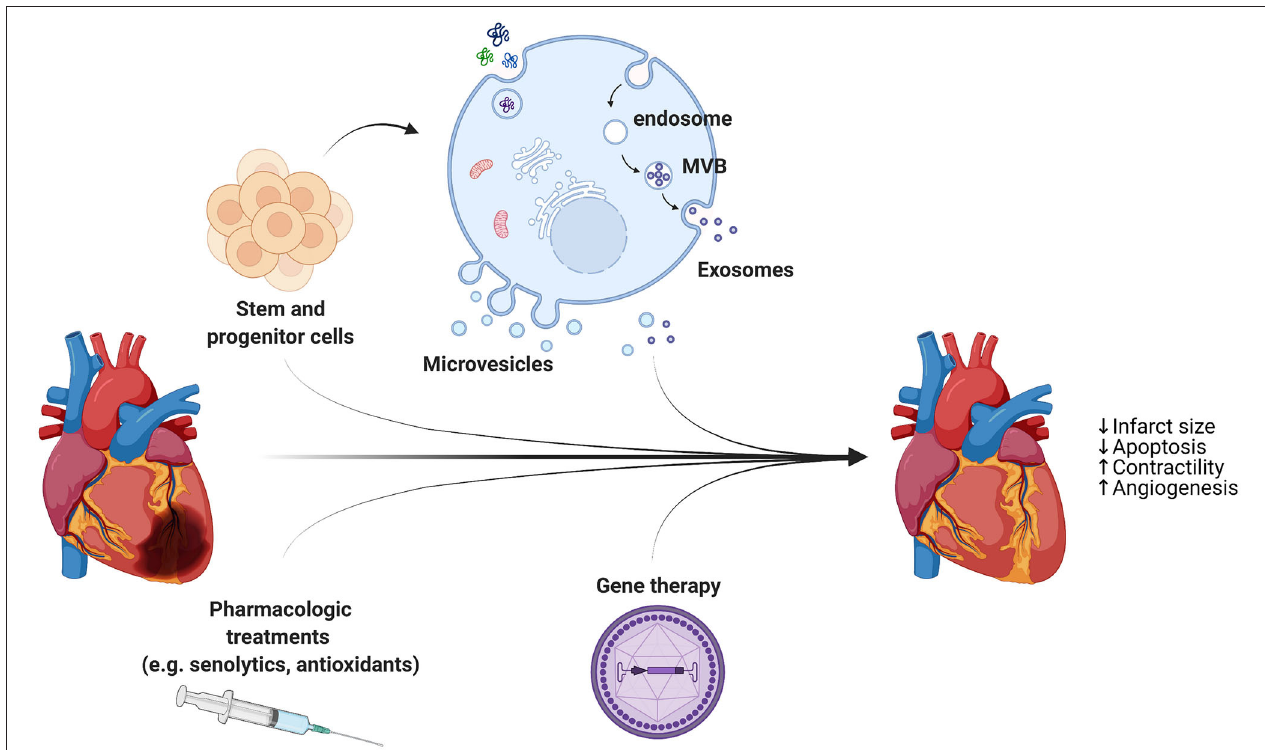
FIGURE 2 | In addition to reperfusion therapy, cardioprotective strategies are necessary to reduce the infarct size and repair the injured myocardium. A combination of different approaches, including stem cell- and progenitor cell-derived extracellular vesicles, pharmacologic treatments, and AAVs for gene therapy, holds great promise for heart regeneration through limiting cell death and stimulating cardiomyocytes proliferation and blood vessel